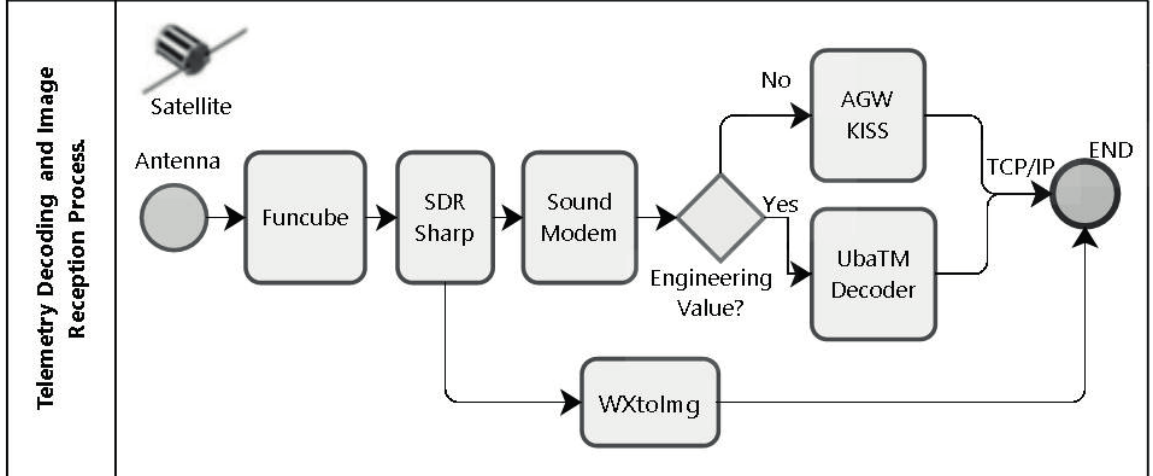
Figure 1 - System diagram of the applied